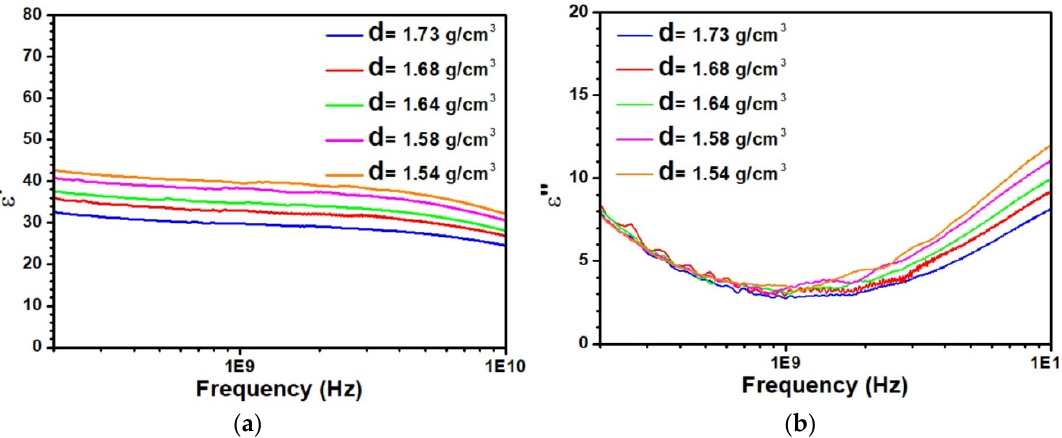
Figure 1. Variation of the relative complex dielectric permittivity as a function of frequency for five different densities ( a ) real part ε ’ and ( b ) imaginary part ε ′′ .